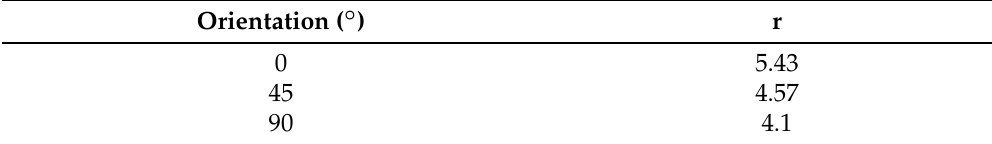
Table 5. Anisotropy coefficients for Grade 2 α titanium.